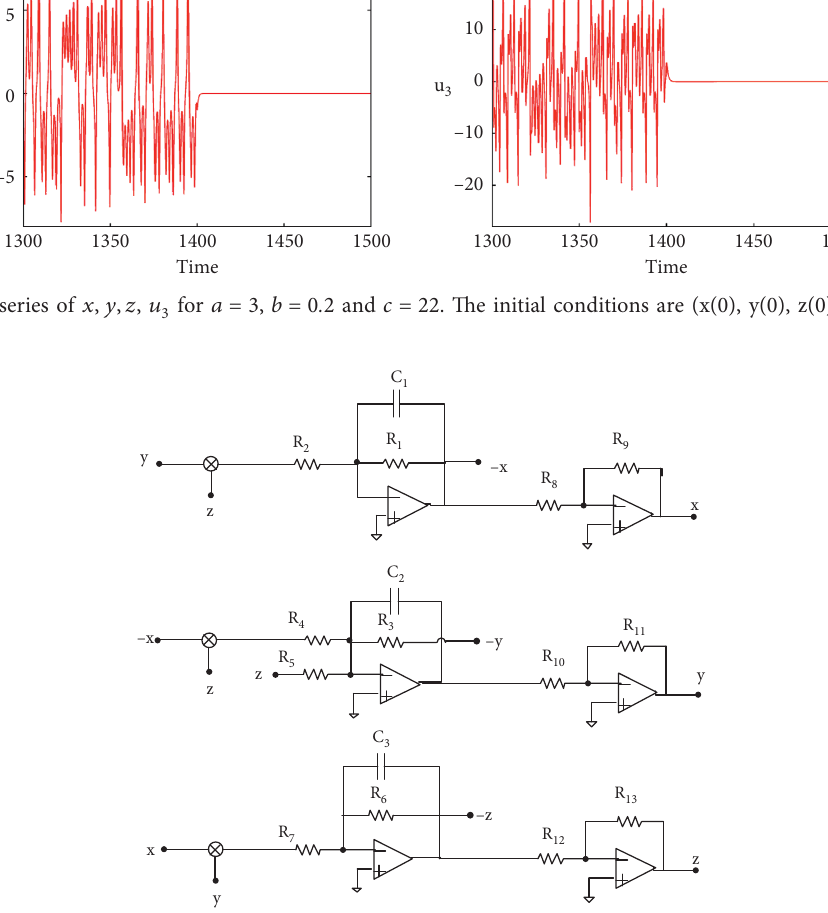
output of the single controller 3 generated from the The good qualitative agreement between the Pspice results of Figure 11 and the numerical simulations results of Figure 6 confirms the efficiency of proposed single controller 3.